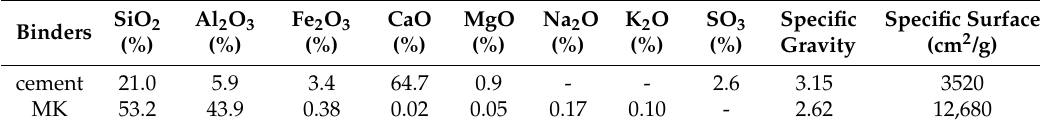
Table 1. The chemical and physical properties of cement and metakaolin.